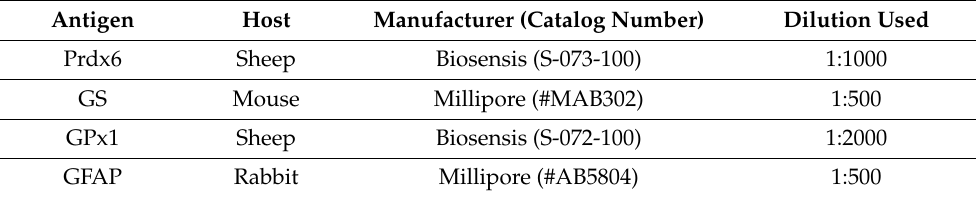
Table 1. Primary antibodies used in the present